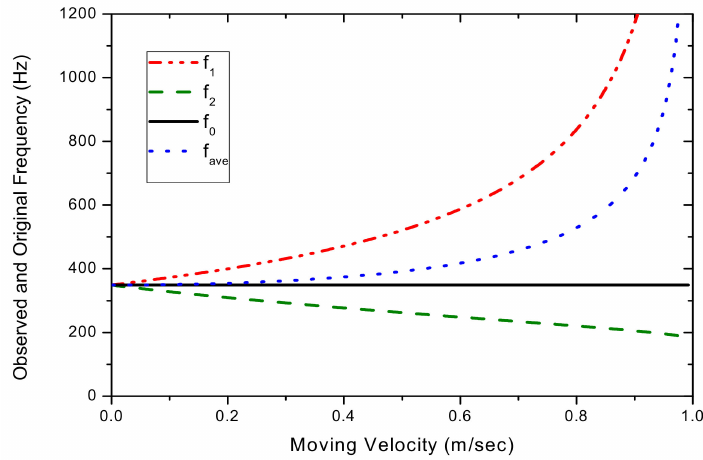
Figure 4. Shifted frequencies f 1 and f 2 and their averages compared with f 0 .